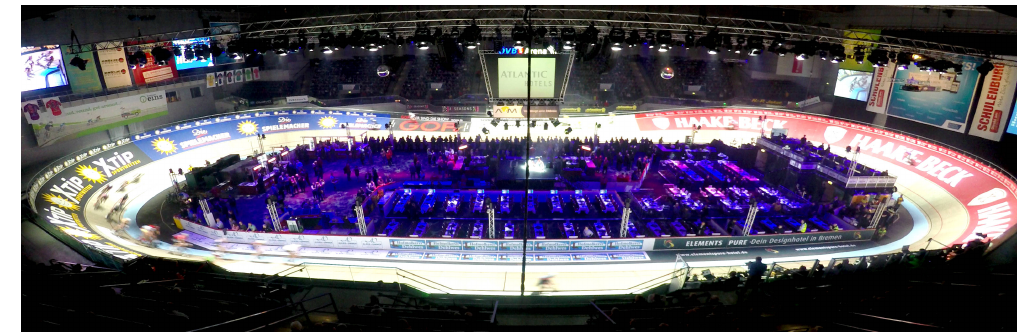
Figure 1. Ref. [11] The track of the Sixdays